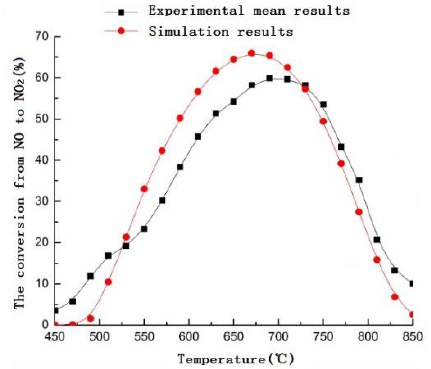
Figure 5. Effect of temperature on the conversion.